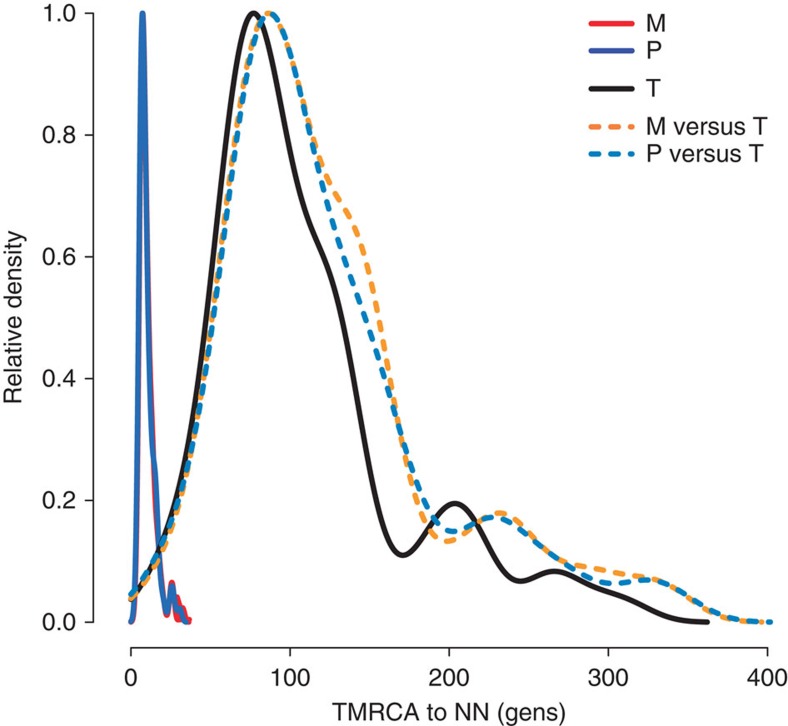
Relative density curves showing the estimated number of generations to the common ancestor between an individual and their NN.The results are from 100 randomly sampled SNPs from across the genome for the MANOLIS individuals (M), the Pomaks (P), the TEENAGE samples (T), each considered separately and a scenario where the MANOLIS individuals (M versus T) and the Pomaks (P versus T) each are forced to select NNs from the TEENAGE cohort.